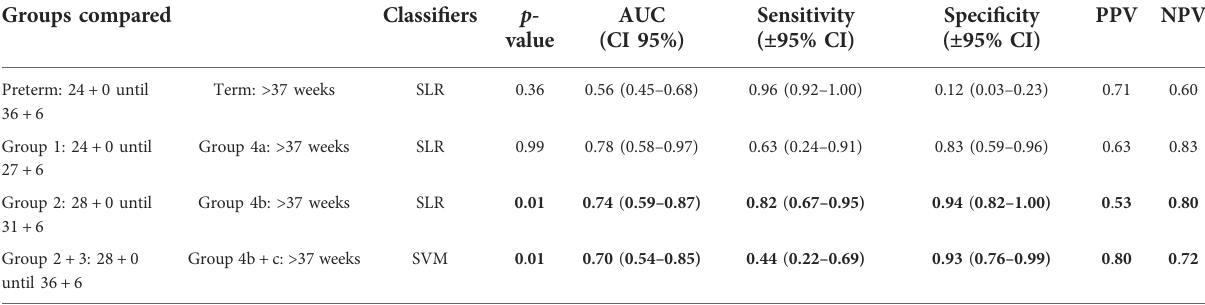
TABLE 2 GC-IMS results for the discrimination of urinary VOC of pregnant women that delivered preterm vs. term. Groups compared